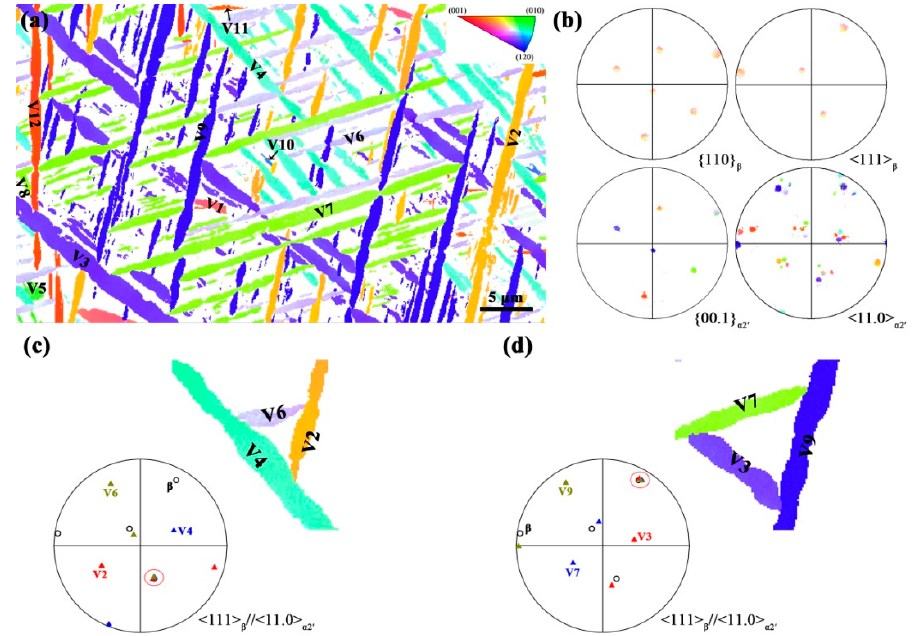
Figure 4. ( a ) The inverse pole figure map shows the orientations of different α 2 ′ variants. The map is corresponds to Figure 2a and the variant numbers are labeled. ( b ) Pole figures for β matrix and α 2 ′ phase, respectively. Note that a Burgers OR is evident. ( c , d ) show two triangular configurations formed by two sets of α 2 ′ variants. For each set the three variants share a common [11.0] α 2 ′ axis which is also parallel to the [111] β direction of the matrix, as outlined by the red cycles.